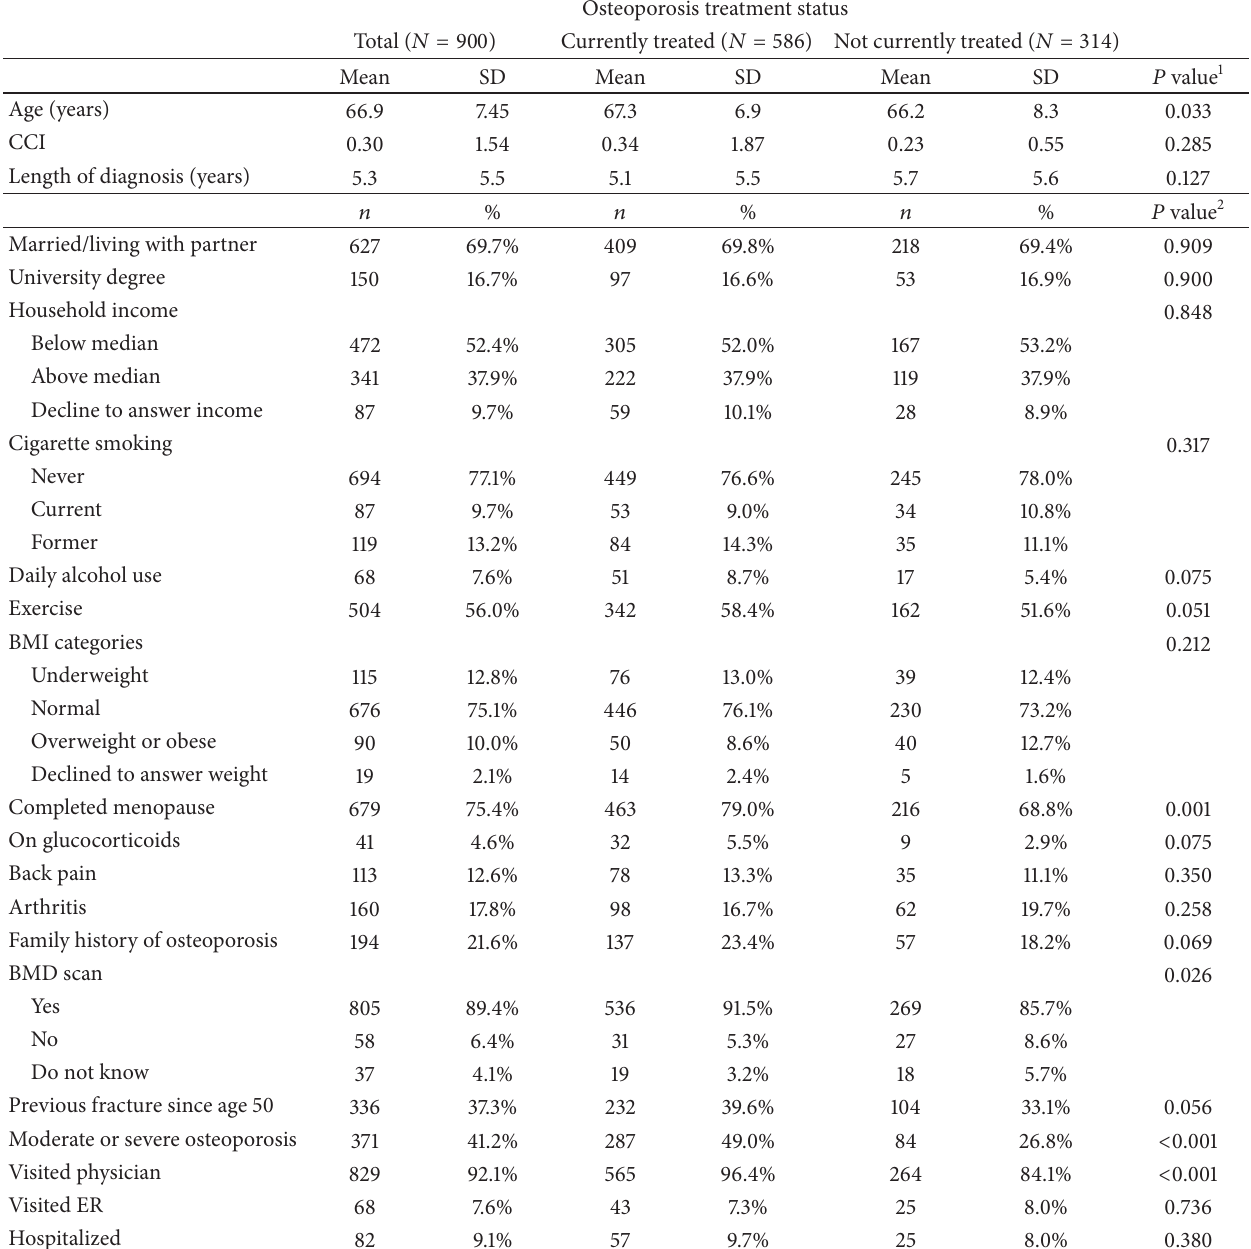
Table 1: Characteristics of women in Japan diagnosed with osteoporosis. Osteoporosis treatment